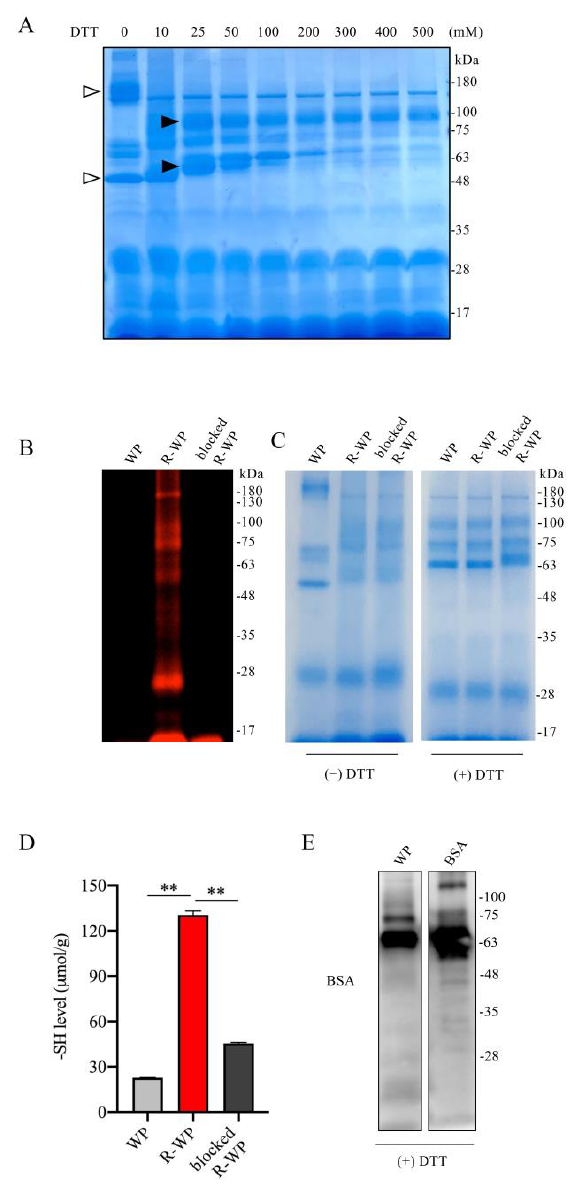
Figure 1. Reductive modification of WPs with DTT leads to an increased number of -SH groups. ( A ) Effect of DTT treatment on WP structure. WP at the concentration of 120 mg/mL was treated with the indicated concentrations of DTT for 30 min at RT. A portion of the treated samples were centrifuged, loaded into 10% SDS-PAGE, separated, and stained with EZ blue. Note the shift in bands after DTT treatment (arrow). ( B – D ) Increased number of -SH groups in R-WP. WP at 120 mg/mL was allowed to react with or without 100 mM DTT overnight at 4 ◦ C. After removing the remaining DTT and other small-molecular metabolites via dialysis, the samples were analyzed for -SH groups using the fluorescence-labeled maleimide probe. Note the markedly increased fluorescence in R-WP that could be blocked entirely with unlabeled maleimide ( B ). To confirm the equal loading of the samples, gels were stained with EZ blue (right image). Because the shift in the bands affected the judgment, the same amounts of the samples were also treated with DTT to confirm the equal